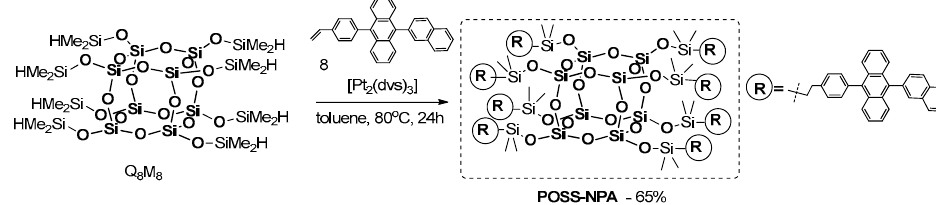
Figure 28. Synthesis of octa(anthracenenaphthyl)silsesquioxane T 8 via hydrosilylation.